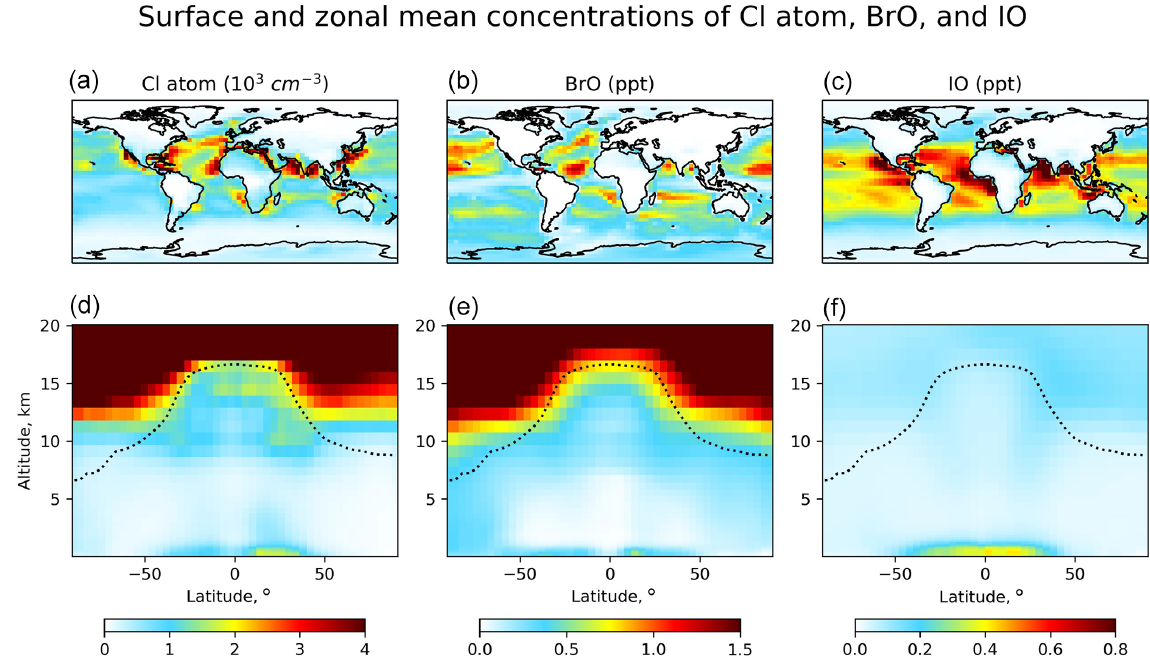
Figure 2. Global distribution of annual mean GEOS-Chem number densities of Cl atoms and mixing ratios of BrO and IO. Panels (a–c) show surface air values, and panels (d–f) show zonal means as a function of latitude and altitude. Dashed lines indicate the tropopause.